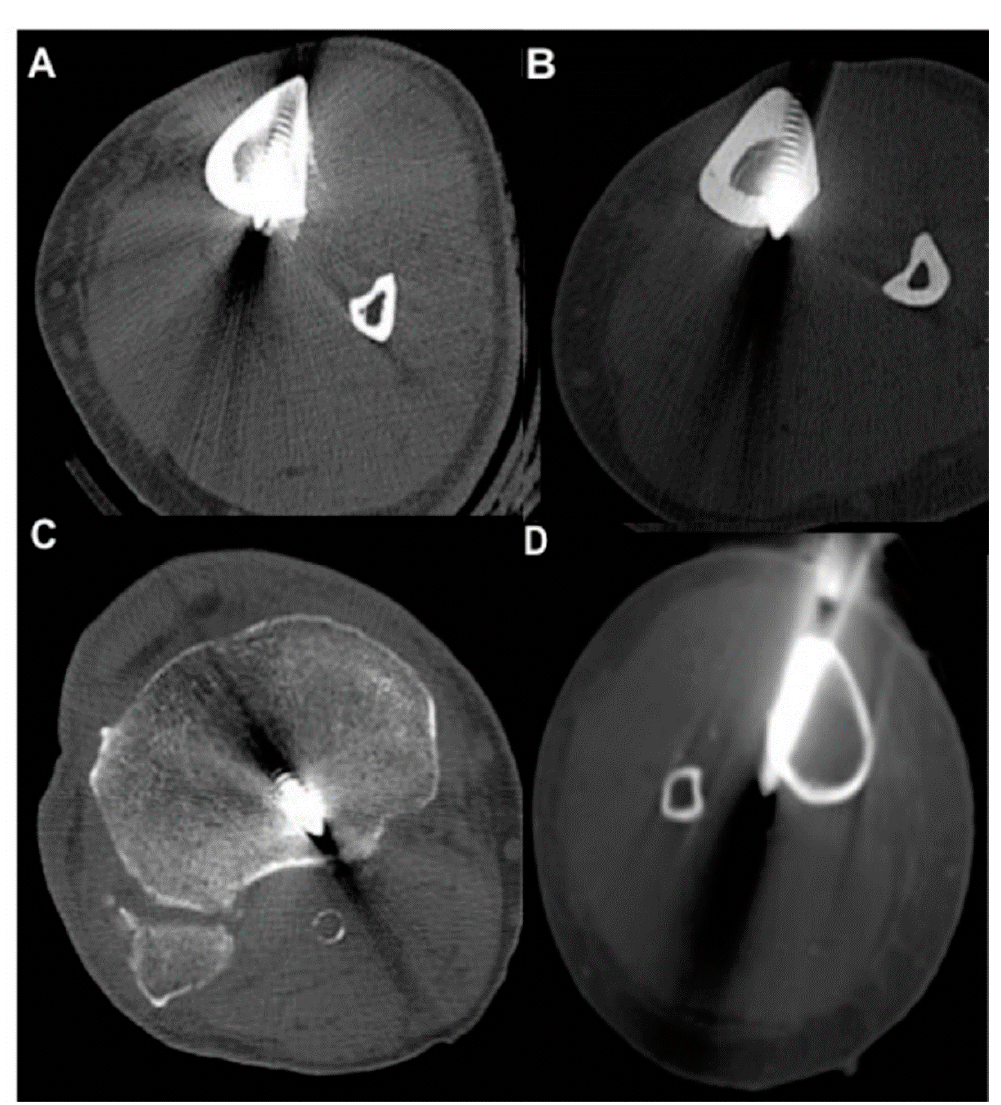
Figure 2. Axial reformatted images in bone window showing: ( A ) Anterior pin application through the tibial crest, ( B ) anterolateral pin application, ( C ) monocortical pin application, and ( D ) transcortical pin application.